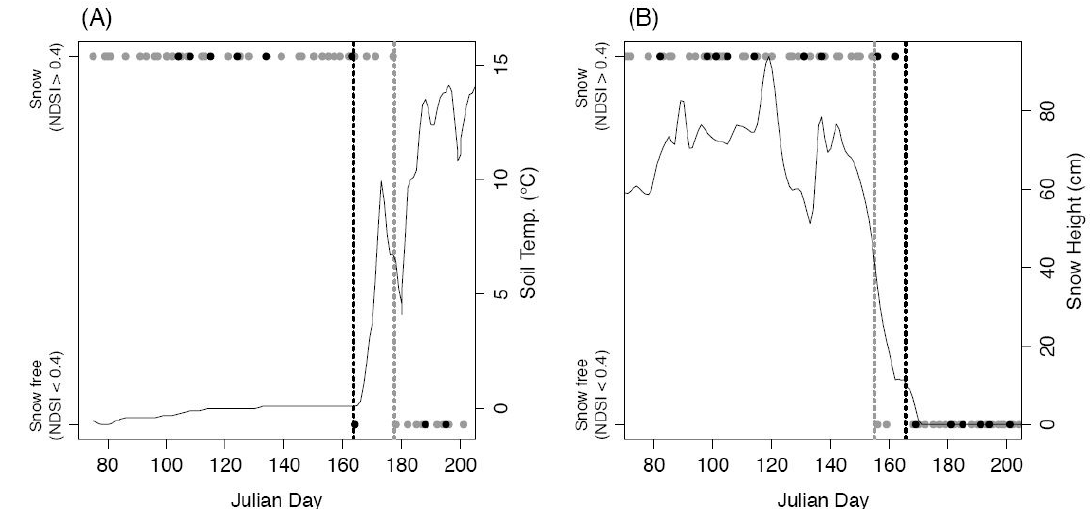
Figure 6. Time series observations for ( A ) a wind-blown dry alpine meadow dominated by Kobresia mesuroides located at 2648 m a.s.l. for 2013; and ( B ) a snow height monitoring station located in a topographic depression at 3100 m a.s.l. in the commune of La Grave for 2015. In ( A ), the line indicates running mean daily measures of soil temperature (°C, k = 3). In ( B ), the line indicates running mean daily measures of snow pack height (cm, k = 3). Solid grey points show MODIS observations of snow cover, while solid black points show SPOT-5 and Landsat-8 observations of snow cover. The black dashed vertical line represents first snow free day estimated by SPOT and Landsat imagery, and the grey dashed vertical line represents the first snow free day estimated by MODIS.